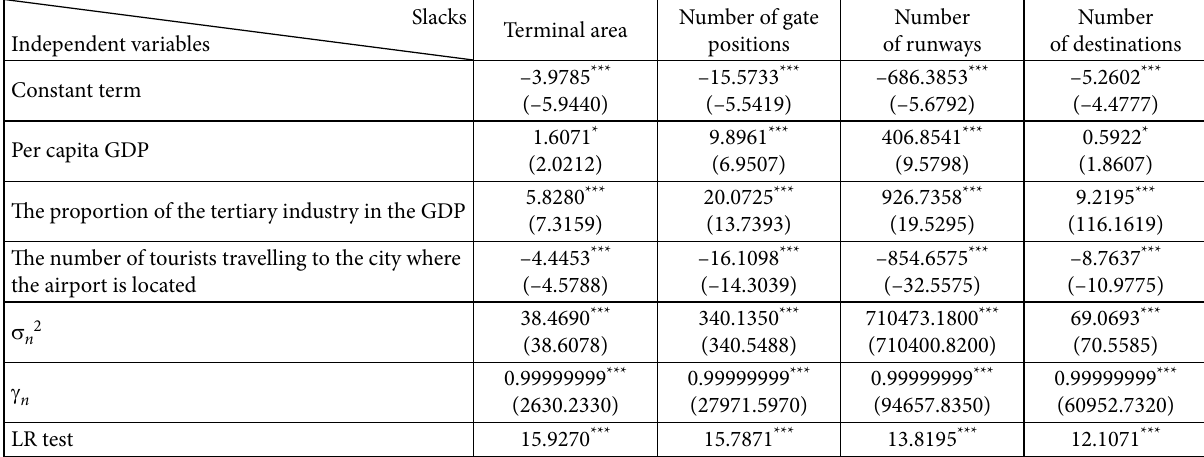
Table B.2. SFA estimation results in